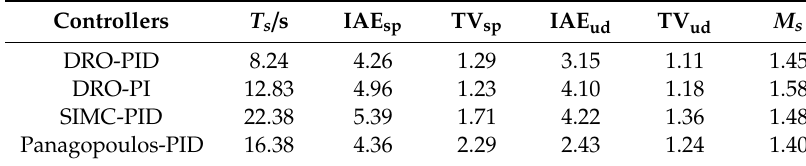
Figure 5. The control signal of the step set-point and input disturbance for Example 1. Table 3. The indices of Example 1 with different controllers.